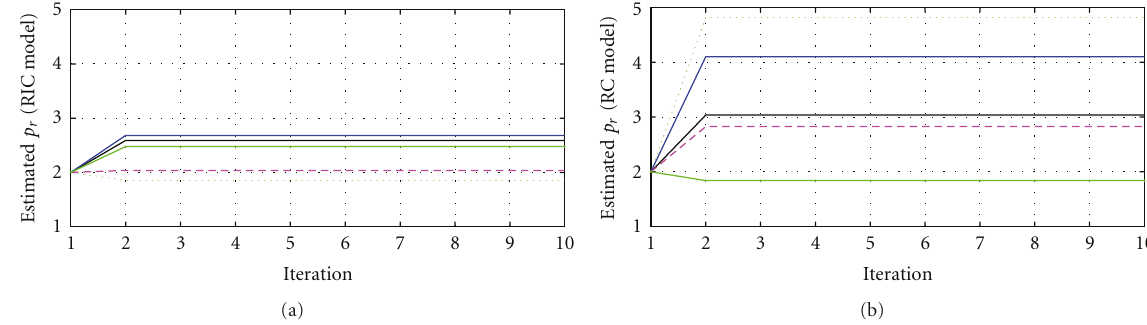
Figure 7: Estimated measurement noise shape factor produced by representative healthy patient (a) for RIC model (b) for nonlinear RC model.